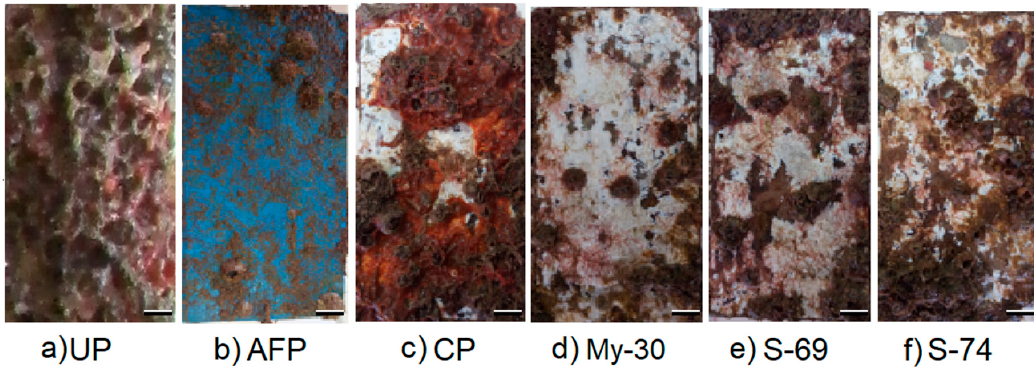
Figure 4. Settlement of organisms in the different treatment after 130 days of immersion in field conditions (Marina of La Paz). ( a ) Structure PVC unpainted (UP), ( b ) Antifouling Paint (AFP), ( c ) control plate with formulated paint (CP), ( d ) supernatant of (My-30), ( e ) supernatant of (S-69) and ( f ) supernatant of (S-74). (Scale bar: 1 cm).